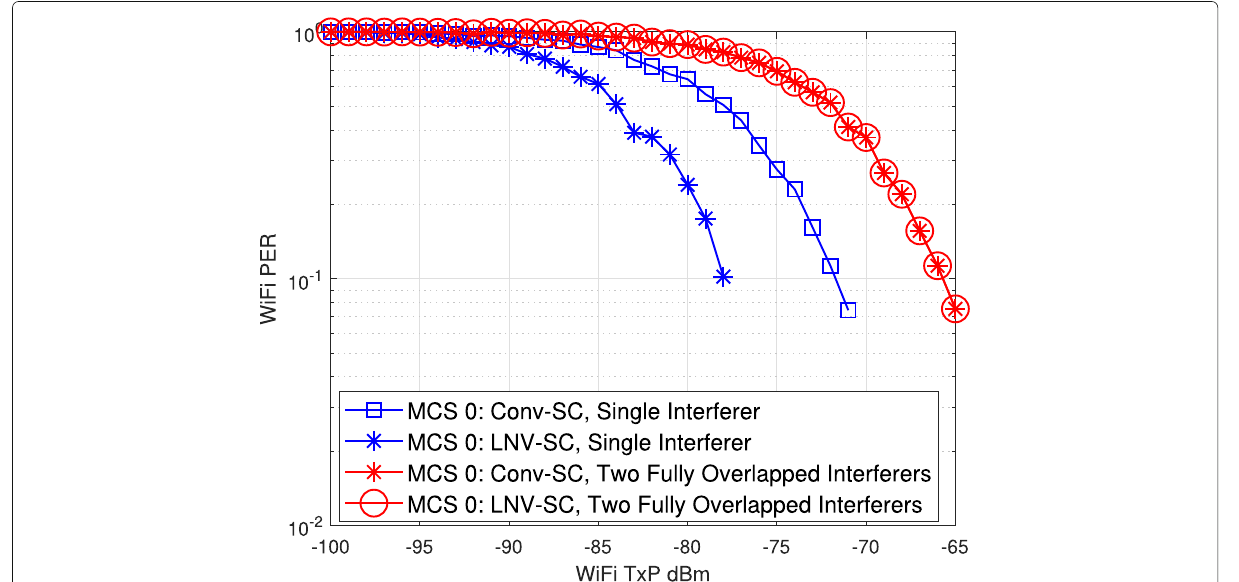
Fig. 11 LNV-SC vs Conv-SC for a single-antenna WiFi receiver in the presence of two fully overlapped narrowband interferers (both at - 85 dBm TxP). LNV-SC fails to provide SNR gain in comparison to